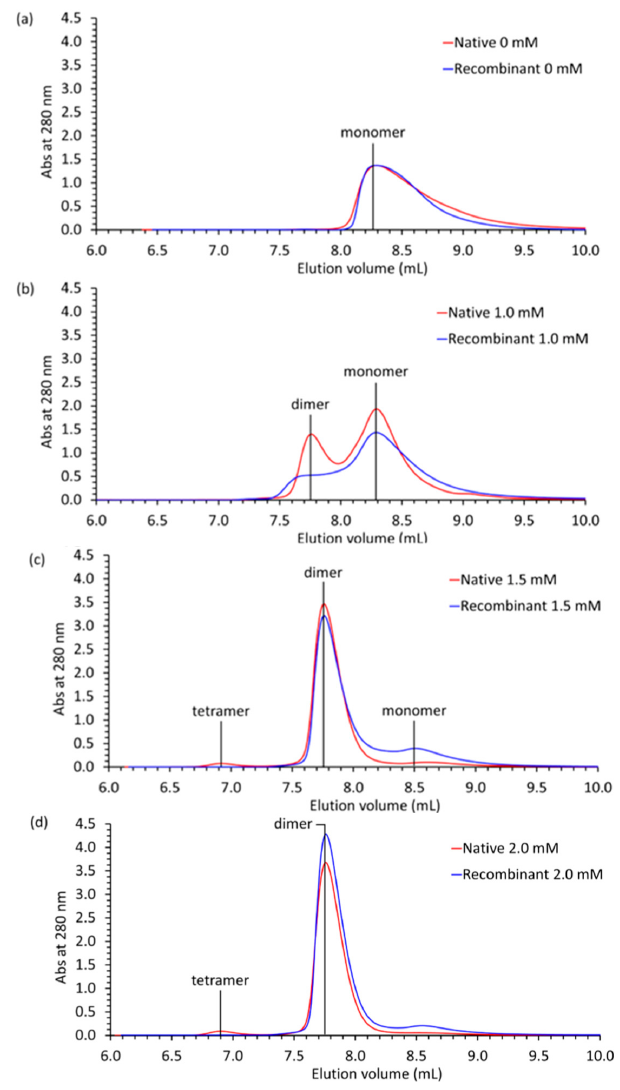
Figure 8. Native (red) and recombinant (blue) bovine Casq1 static light scattering/size-exclusion chromatography profiles, plotted as absorbance at 280 nm versus elution volume, in buffer containing either ( a ) 0, ( b ) 1.0, ( c ) 1.5 or ( d ) 2.0 mM Ca 2+ .